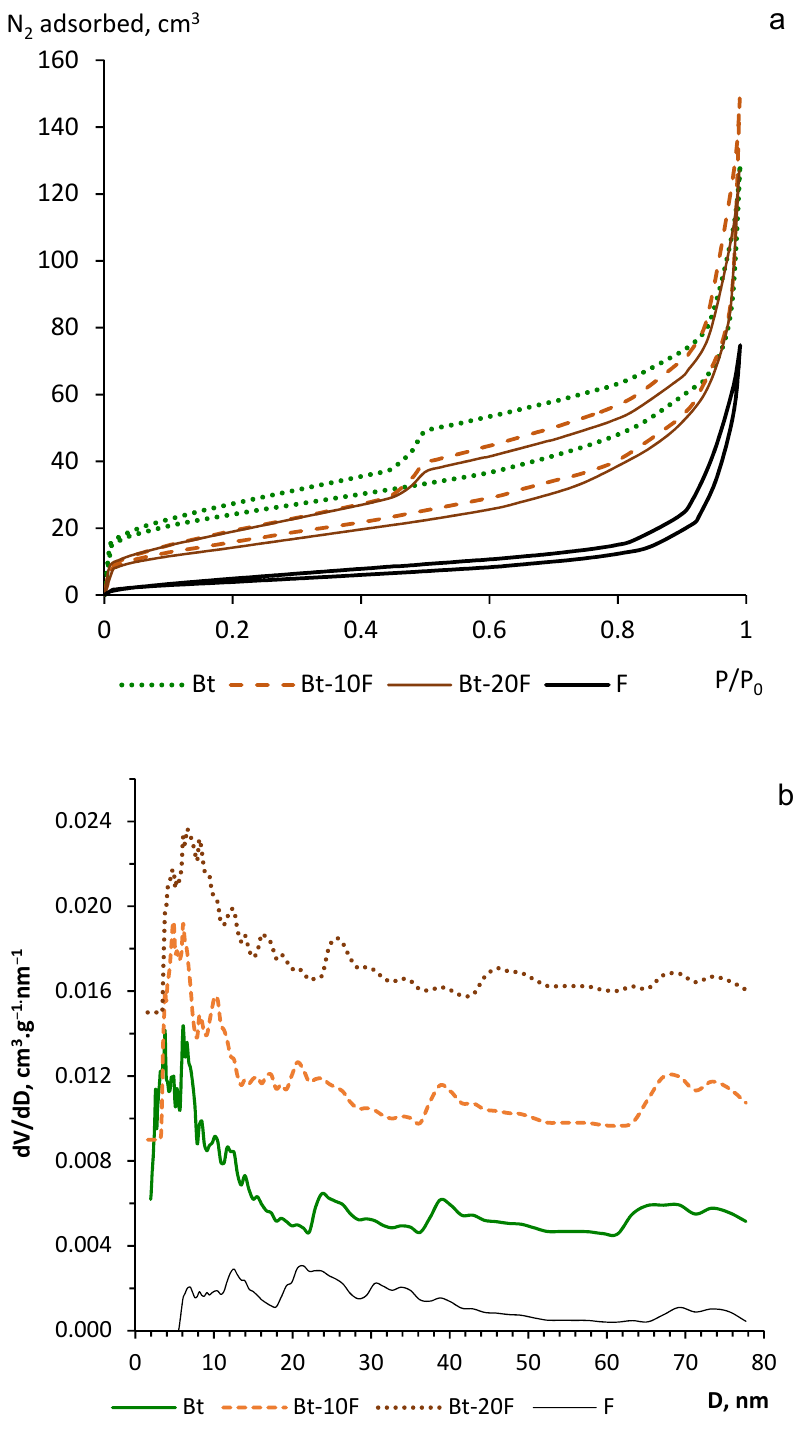
Figure 4. Isotherms of N 2 adsorption-desorption ( a ) and pore size distribution ( b ) for samples of Bt, Bt-10F, Bt-20F and cobalt ferrite (F).